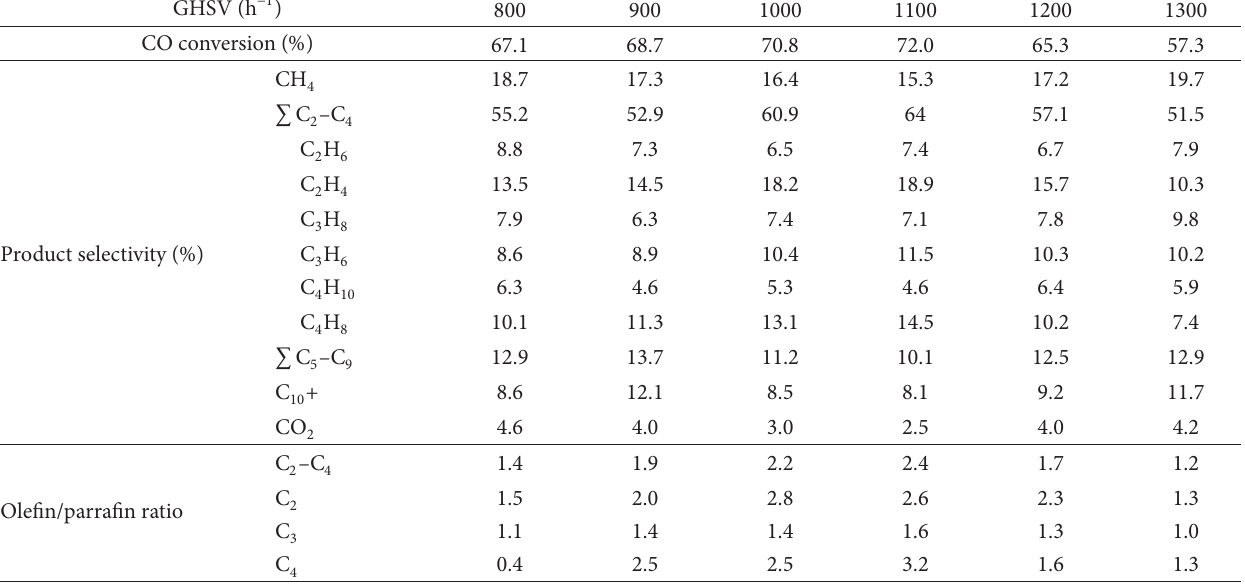
T 5: Effect of different GHSV on the catalytic performance of catalyst a .